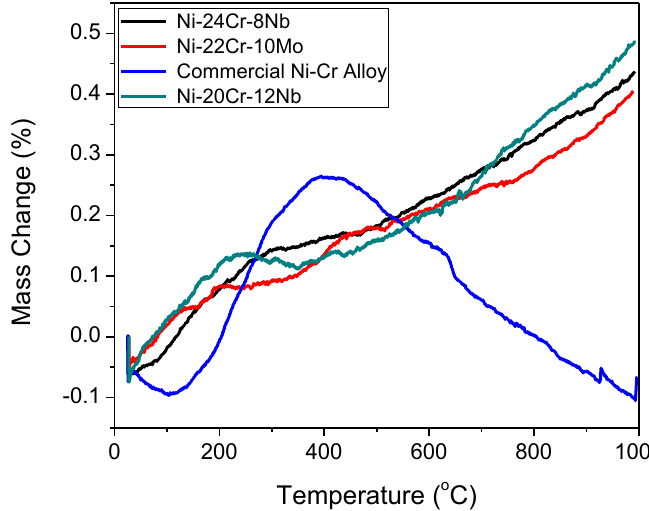
Figure 4. Representative thermogravimetric curves of the commercial Ni-Cr alloy, and as-cast Ni-Cr-Nb and Ni-Cr-Mo alloys evaluated in this work.